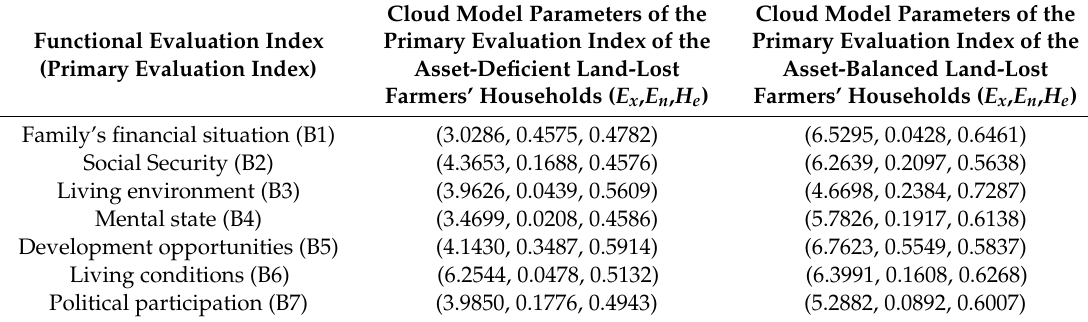
Table 6. Cloud model parameters of primary evaluation indicators for the welfare e ff ects of land-lost farmers’